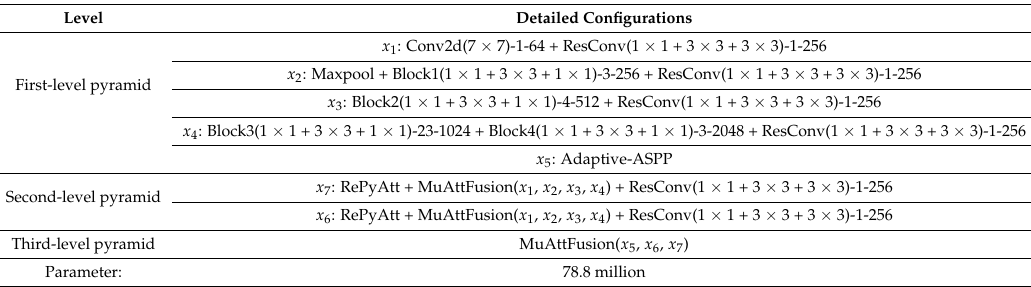
Table 1. Three-level heavy-weight spatial FFPNet configurations. The module parameters are denoted as “module name(receptive fields of different convolutions)-number of modules-number of module output channels”. Note that some complex modules only give the module